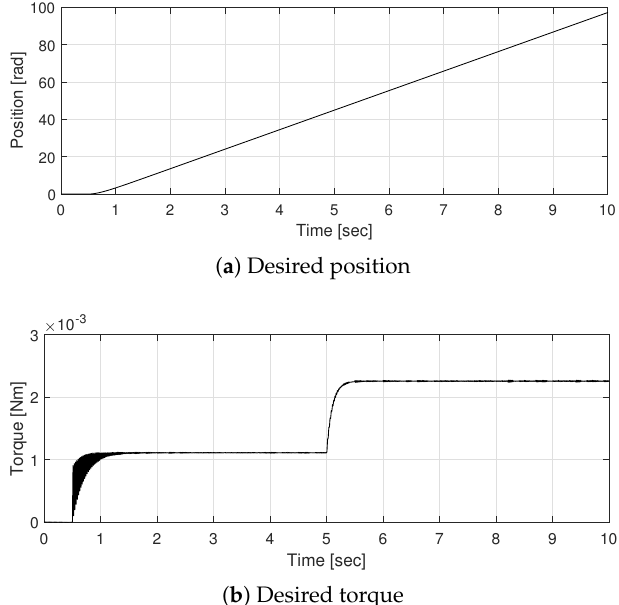
Figure 4. Desired position and desired torque.